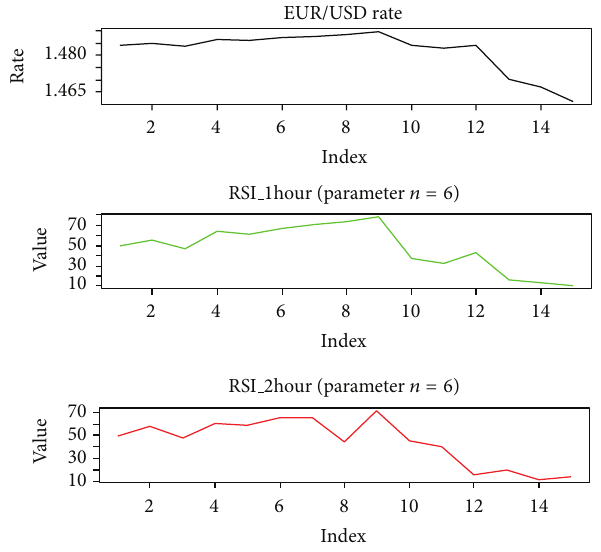
Figure 1: Example showing the relative strength index values from multiple